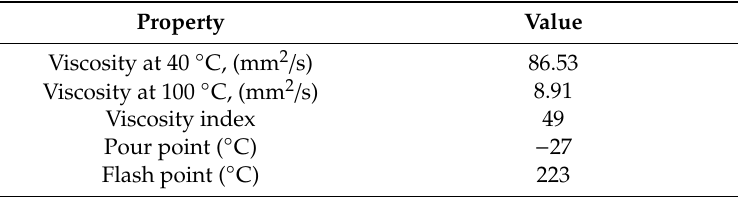
Table 1. Physico-chemical properties of LA-based polyol Table 1. Physico ‐ chemical properties of LA ‐ based polyol ester.